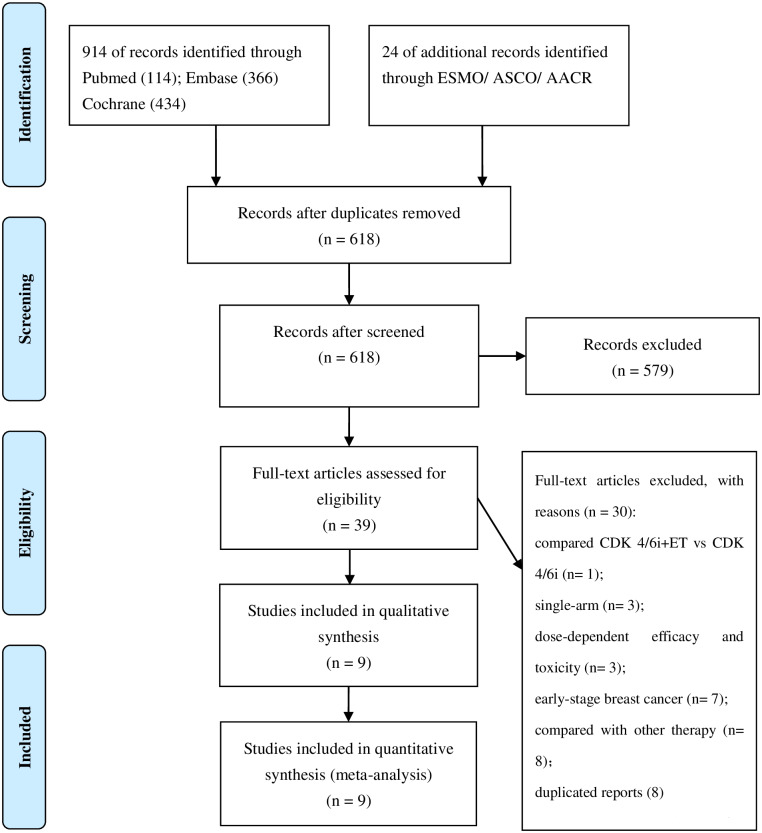
Flow diagram for inclusion and exclusion of studies.ESMO: European Society for Medical Oncology; ASCO: American Society of Clinical Oncology; AACR: American Association for Cancer Research.